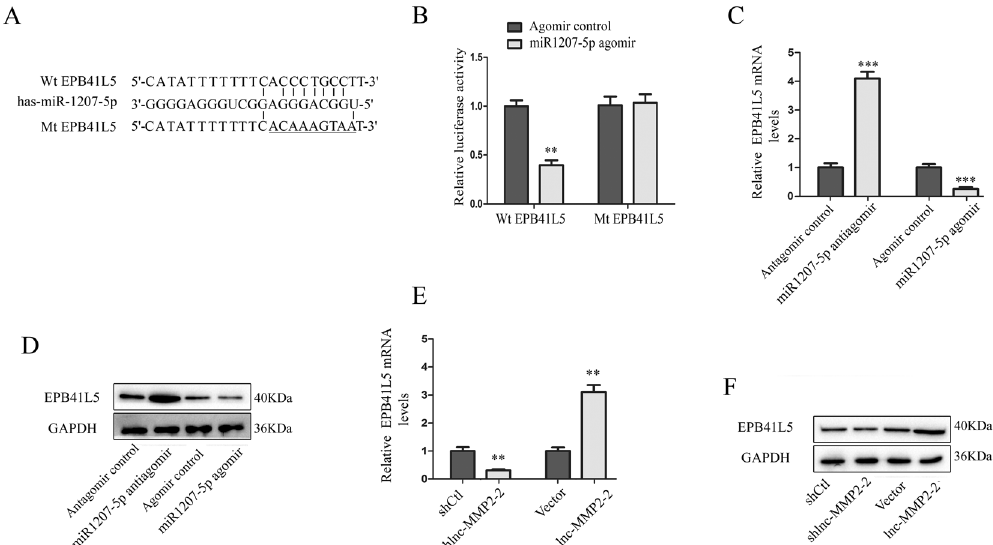
Fig. 5 EPB41L5 is a direct target of miR-1207-5p in HBMECs. A Bioinformatics analysis showed that miR-1207-5p could directly target the 3 ′ - UTR of EPB41L5 wild-type (Wt). EPB41L5-mutant (Mt) means mutation of binding sites in the 3 ′ -UTR of EPB41L5. B miR-1207-5p negatively regulates the luciferase activity of Wt EPB41L5, rather than that of Mt EPB41L5 in HBMECs. C , D miR-1207-5p inversely regulates the level of EPB41L5 mRNA and protein in HBMECs. E , F lnc-MMP2-2 positively regulates the abundance of EPB41L5 mRNA and protein in HBMECs. ** p < 0.01, *** p <